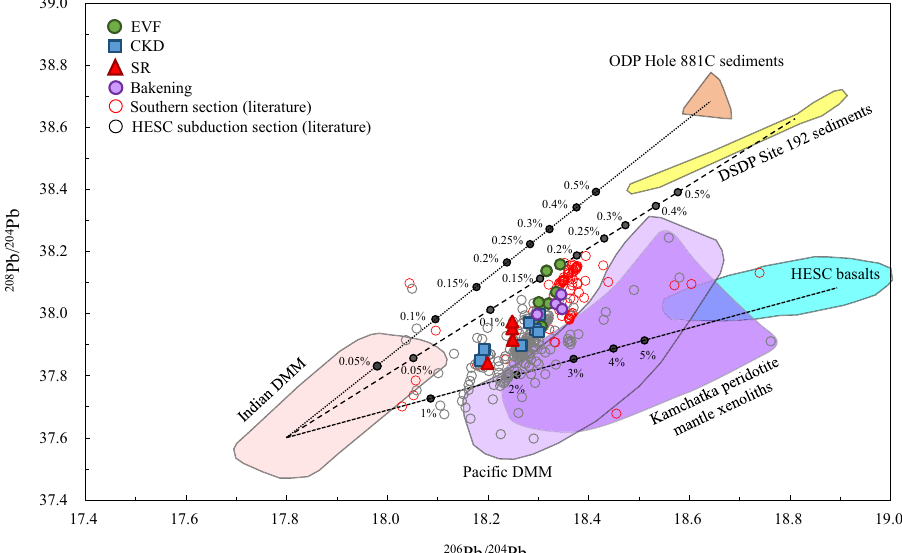
Fig. 5 | Lead isotope characteristics for Kamchatka lavas and subducting materialsoutboard ofKamchatka arc. 206 Pb/ 204 Pbversus 208 Pb/ 204 Pb diagramfor Kamchatka lavas that have been fi ltered for deep ocean-island-basalt (OIB) com- ponents from Ichinsky volcano lavas. Also shown are the Paci fi c and Indian depleted MORB mantle (DMM) 75,124 , Kamchatka peridotite mantle xenoliths in fi l- trated by fl uids 77 , sediments and Hawaii-Emperor Seamount Chain (HESC) from